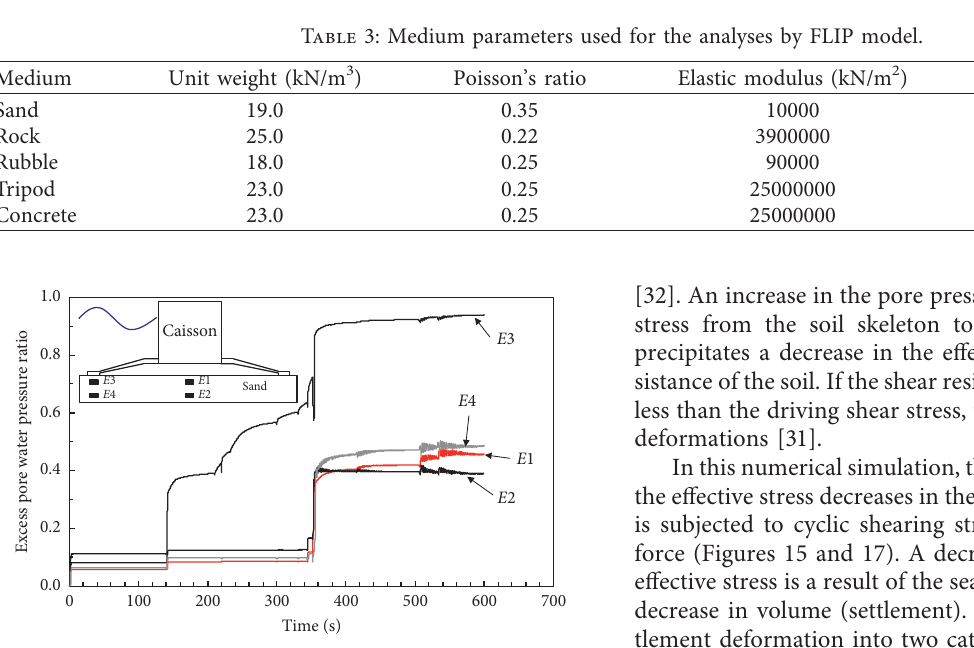
Figure 15: Time history of excess pore water pressure